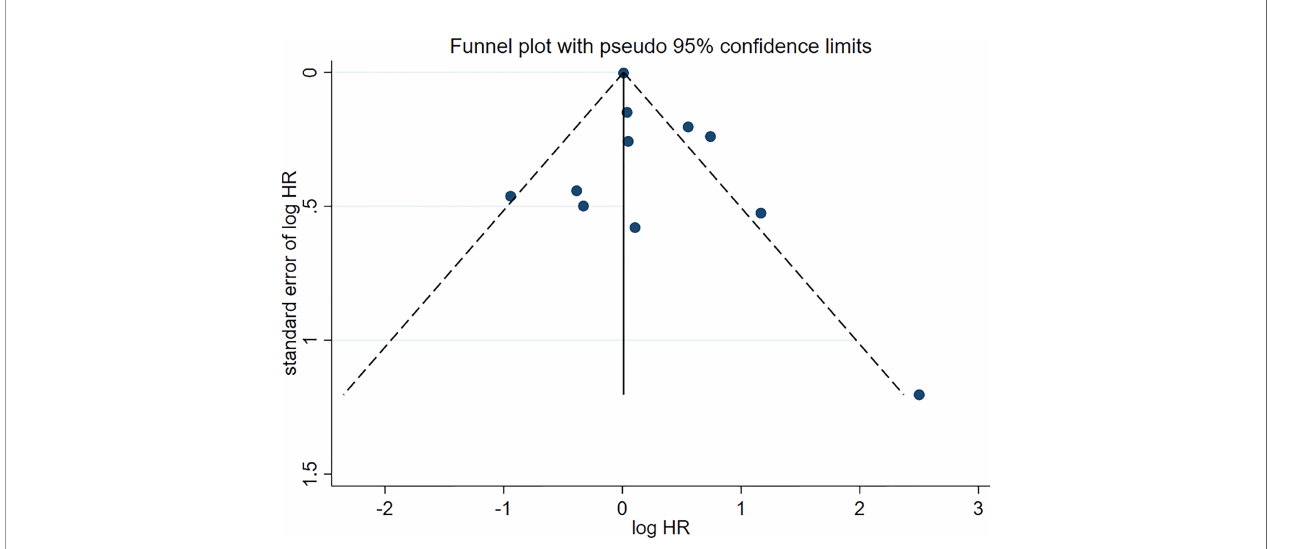
FIGURE 5 | Funnel plot of publication